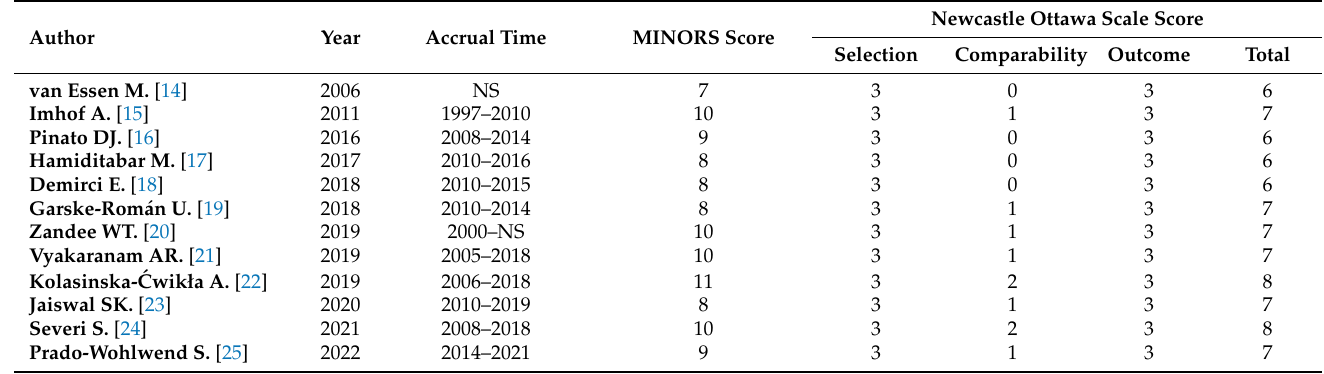
Table 3. MINORS and Newcastle-Ottawa Scale scores of selected articles.